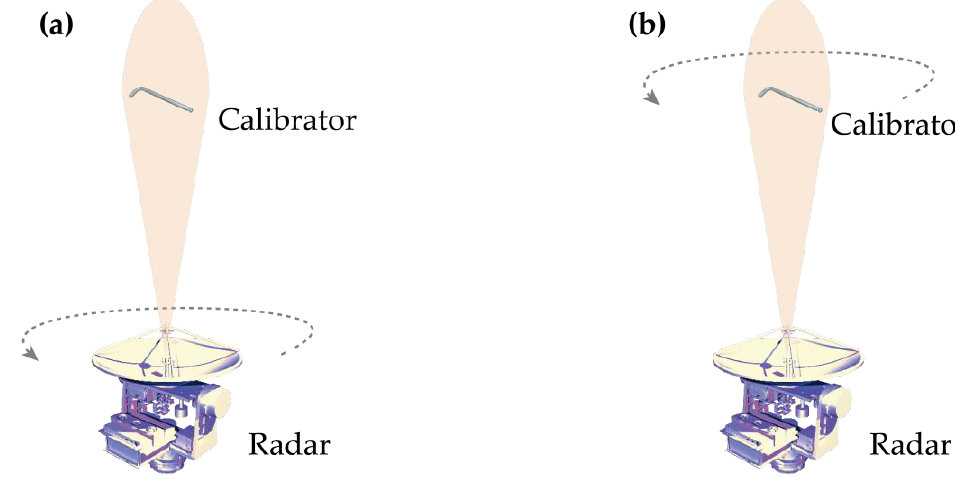
Figure 2. Schematic diagram of PCTAR. ( a ) Rotate the antenna; ( b ) Rotate the calibrator. The steps and calculation methods of PCTAR polarization calibration technique are described in detail below. When the rotation angle is 0°, taking the H-polarization di-